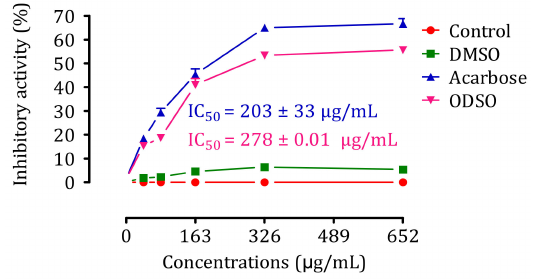
Figure 9. Inhibitory effect of the intestinal α -glucosidase activity by ODSO and acarbose in vitro. The values are the means ± SEM ( n = 3). ODSO: Opuntia dillenii seed oil.